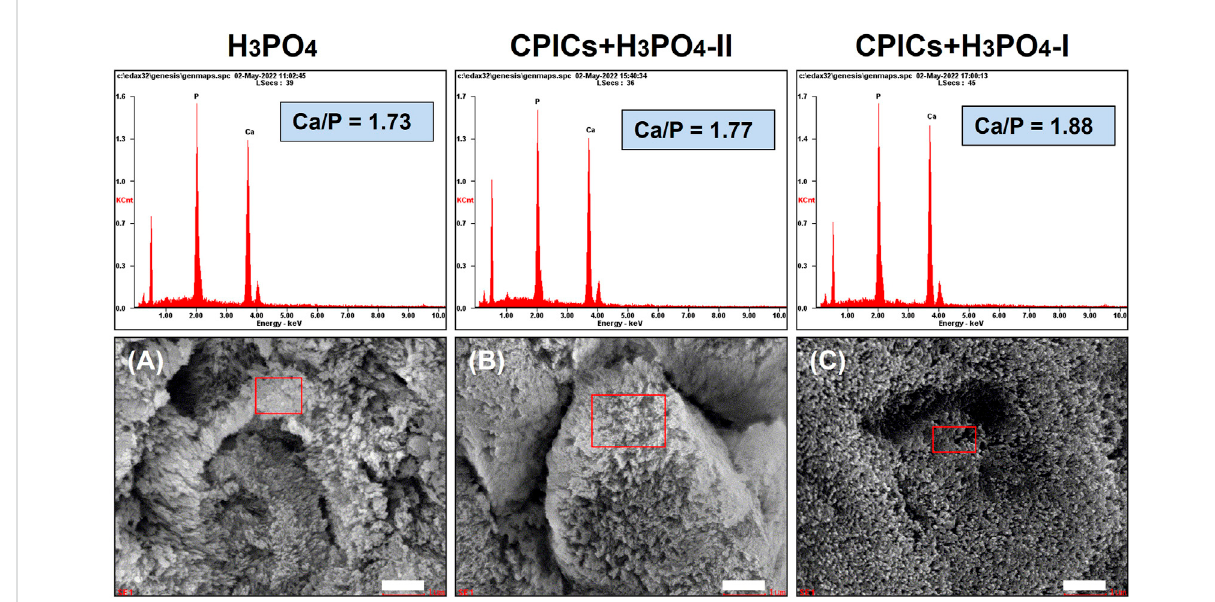
FIGURE 5 Scanningelectronmicroscope(SEM)imagesandenergydispersiveX-rayspectrometer(EDX)spectrafortheacid-etchedenamelspecimens(A,